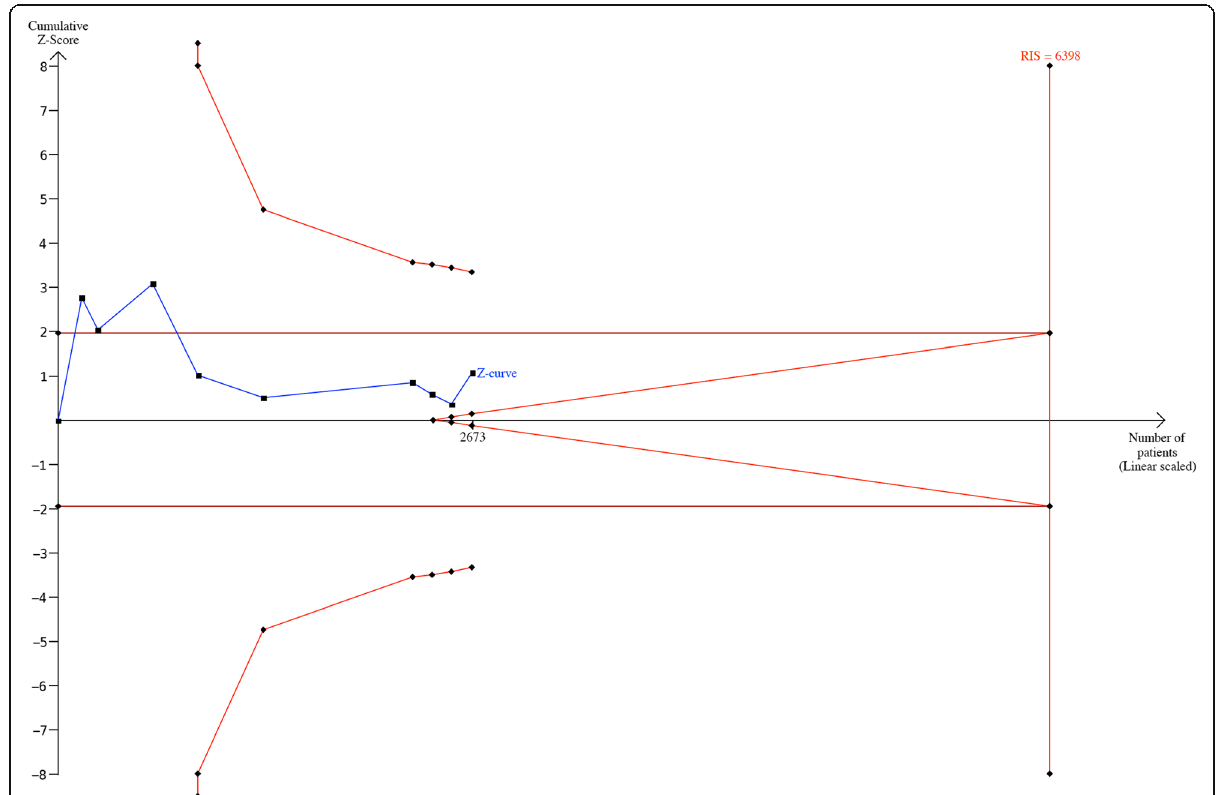
Fig. 3 TSA of the analysis on the association between IL-6 -174 G/C polymorphism and the risk of sepsis in non-adults under dominant model. A type I error of 5%, power of 80%, relative risk reduction of 20% were defined and control event proportion was an average of each included study. The vertical red line represents the required information size (sample size). The red curves represent the O ’ Brien-Fleming boundary and futility boundary. The blue line represents the cumulative Z-curve. RIS, required information